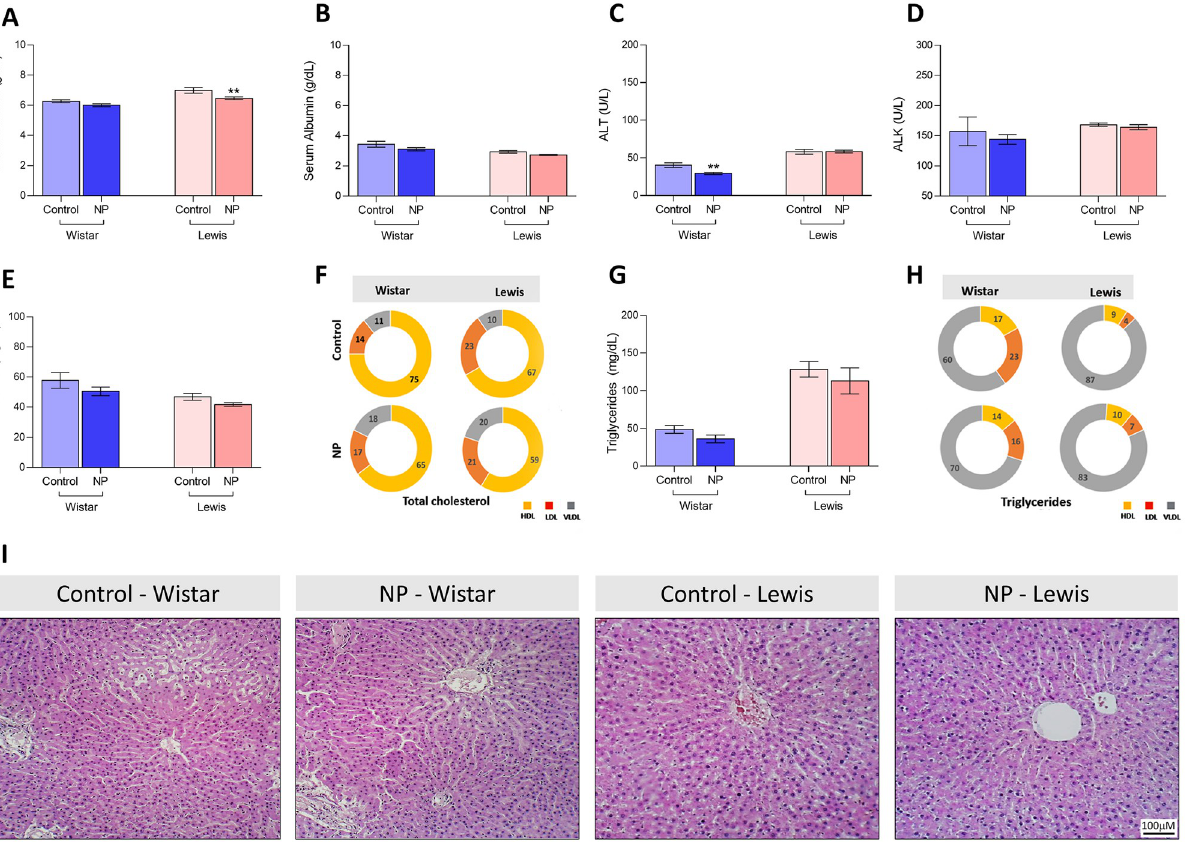
Fig 1. Hepatic Function: Serum A) Protein (g/dL), B) Albumin (g/dL), C) ALT (U/L), D) ALK (U/L), E) Total cholesterol (mg/dL), F) Cholesterol fractions (%, HDL in yellow, LDL in red and VLDL in gray) G) Total triglycerides (mg/dL) and H) Triglyceride fractions (%, HDL in yellow, LDL in red and VLDL in gray). I) Illustrative microphotographs of HE-stained liver sections under final 100x magnification.